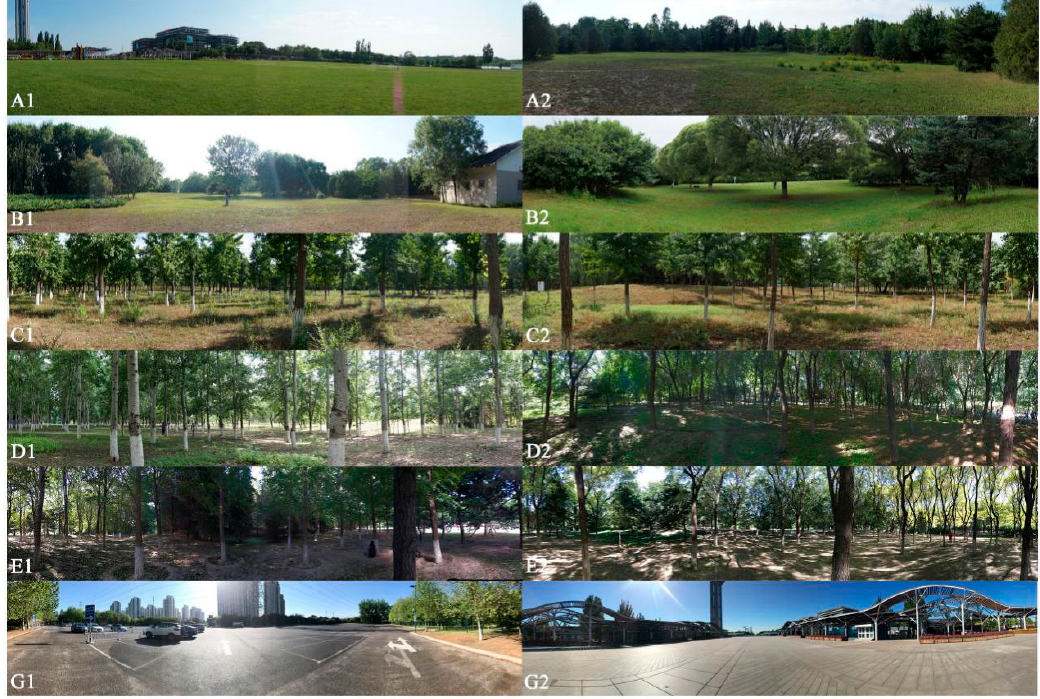
Figure 2. Panoramas of five different vegetation structure green spaces and gray spaces.